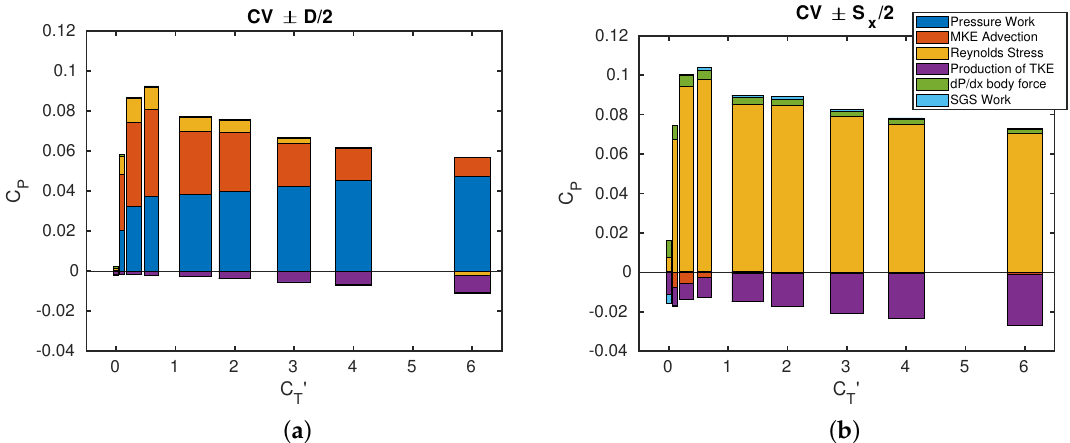
Figure 12. Detailed breakdown of C P budget by term in the MKE budget equation, plotted as a function of as a function of C (cid:48) , and comparing two different streamtube control volumes. ( a ) budget breakdown T for the small control volume, with streamwise extent of 1 turbine diameter. ( b ) budget breakdown for the large control volume, with streamwise extent of one row